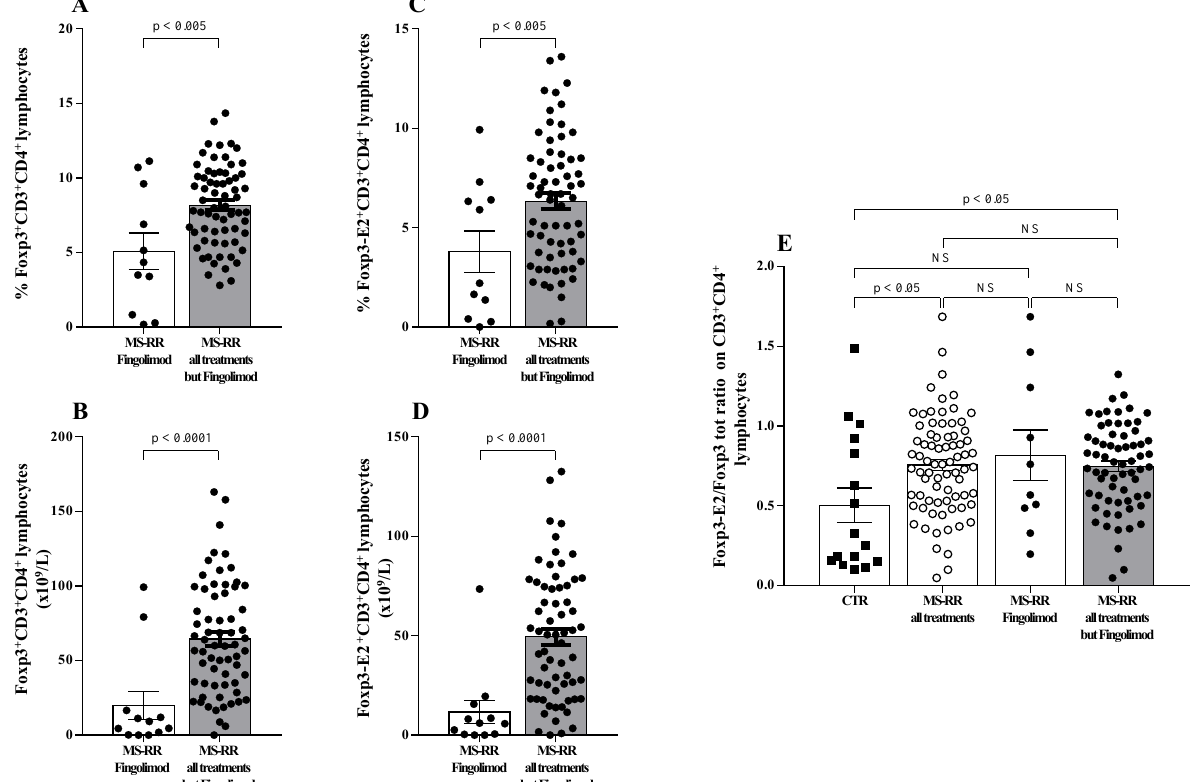
Figure 3. MS-RR individuals undergoing immune-modulating treatments, except fingolimod showed a Treg percentage and number significantly higher than the controls. White column with black dots represents the MS-RR individuals undergoing fingolimod therapy and grey column with black dots indicates the MS-RR subjects undergoing all treatments, except fingolimod. ( A , B ) Percentage and number of Treg cells, evaluated by Foxp3 expression in CD4 + lymphocytes. ( C , D ) Percentage and number of Treg cells evaluated by Foxp3-E2 expression in CD4 + T lymphocytes. ( E ) Comparative analysis of Foxp3-E2/whole Foxp3 ratio. Statistical evaluation of data was performed by means of the Mann–Whitney